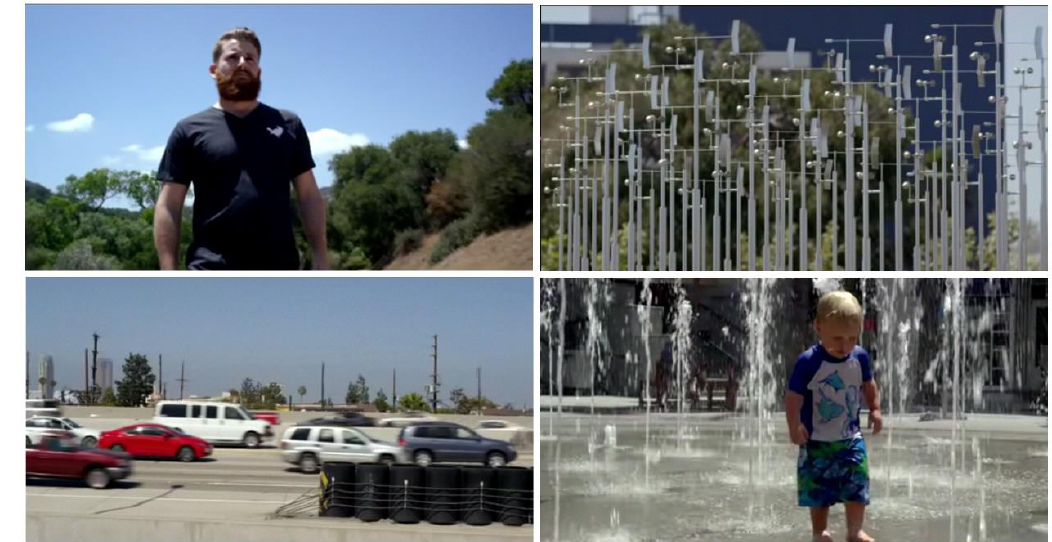
Figure 9. Transmitted sequence of video content.